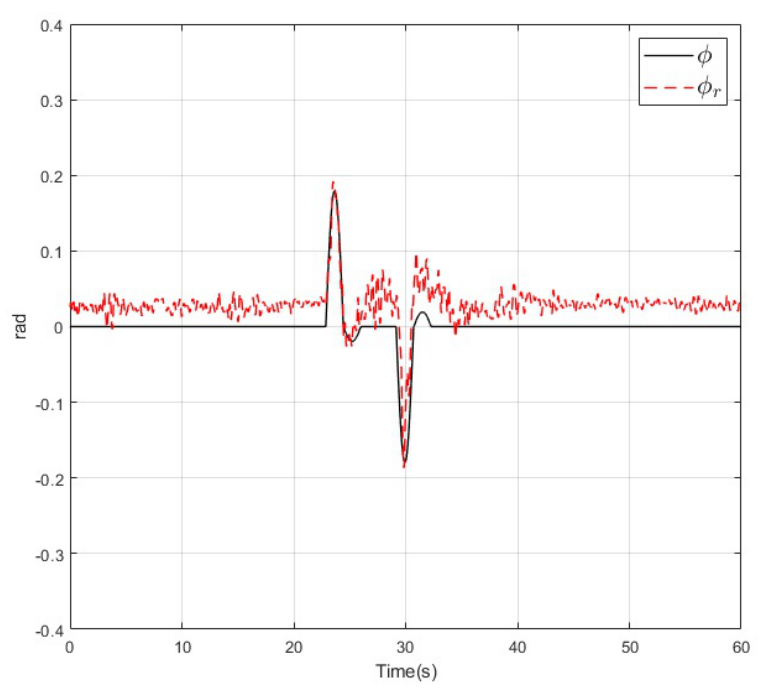
Figure 14. Roll angle (dashed) and its reference (solid) during the real-time experiment.